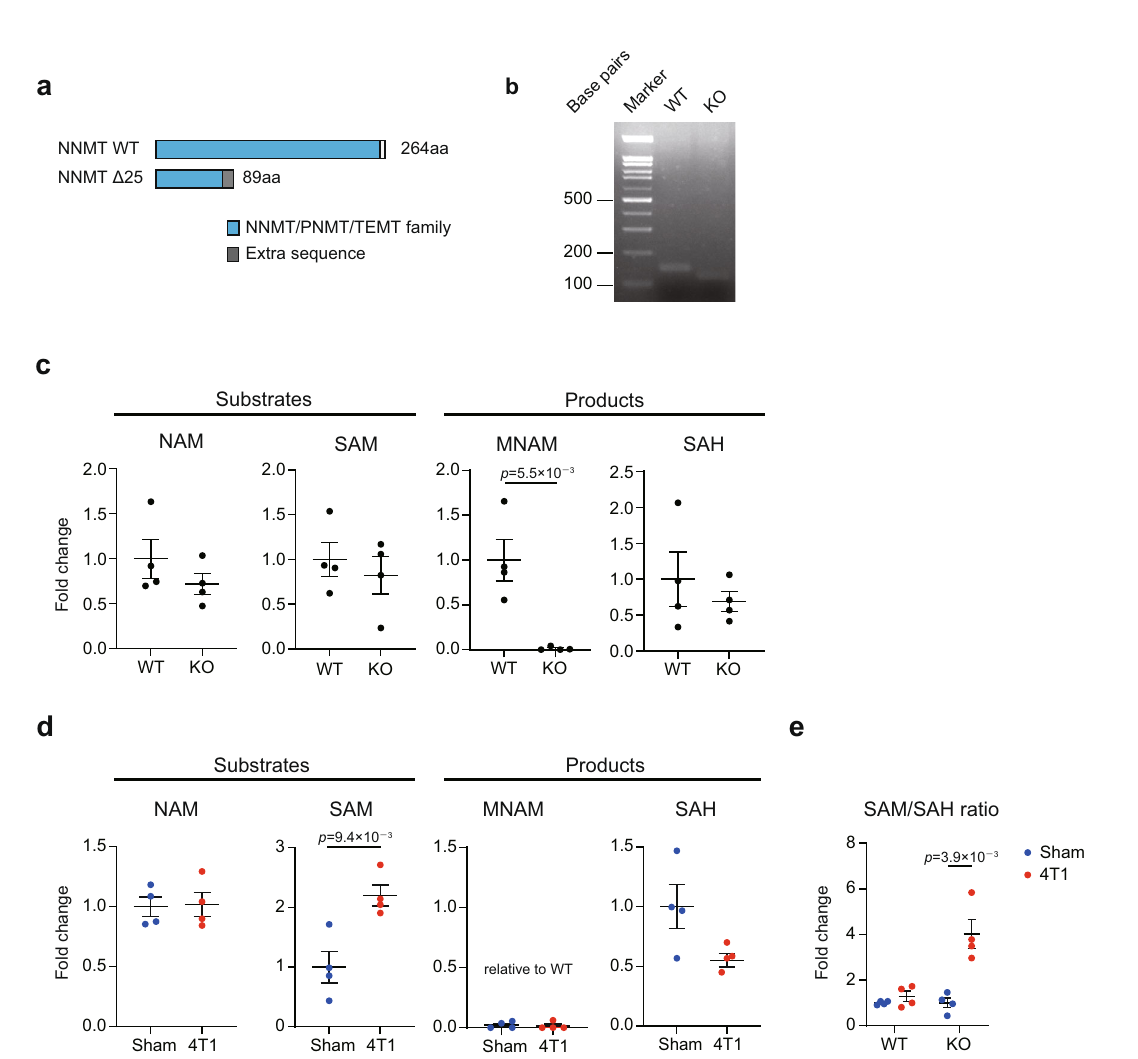
Fig. 2 Nnmt KO abolishes MNAM and accumulates SAM in a cancer-bearing condition. a The Nnmt KO ( Δ 25 allele) was generated by the CRISPR-Cas9 technique in this study. b The representative picture for genotyping BALB/c Nnmt KO mice. c LC-MS/MS analysis for the NNMT-related metabolites in the livers of WT and Nnmt KO mice. n = 4. d LC-MS/MS analysis for the NNMT-related metabolites in the livers of Nnmt KO mice in the 4T1 transplantation experiments. n = 4. e The SAM/SAH ratio of sham-operated and 4T1-bearing WT and Nnmt KO mice. n = 4. c – e The exact p values are shown (unpaired two-tailed Student ’ s t -test). Averaged fold change data are presented as the mean ± SEM. Source data are provided as a source data fi Nnmt deletion buffers multi-omics changes caused by 4T1 4T1 transplantation severely depleted NAD in the liver. Nnmt KO breast cancer . On the basis of the data presented in Figs. 1, 2, we partially buffered the cancer-induced NAD depletion. Importantly, owing to the lack of MNAM in Nnmt KO, the expected that NNMT might play roles in cancer-induced increase of MNAM by 4T1 breast cancer in the livers of WT was abnormalities in the liver via regulation of the methyl-donor completely canceled (Figs. 1d, 2d). Thus, in 4T1 breast cancer- balance and/or MNAM. To test this idea, we performed multi- bearing mice, Nnmt KO resulted in the accumulation of SAM omics analyses (transcriptome and metabolome) on the livers of while canceling the anticipated increase of MNAM in the liver. 4T1 breast cancer-bearing mice.